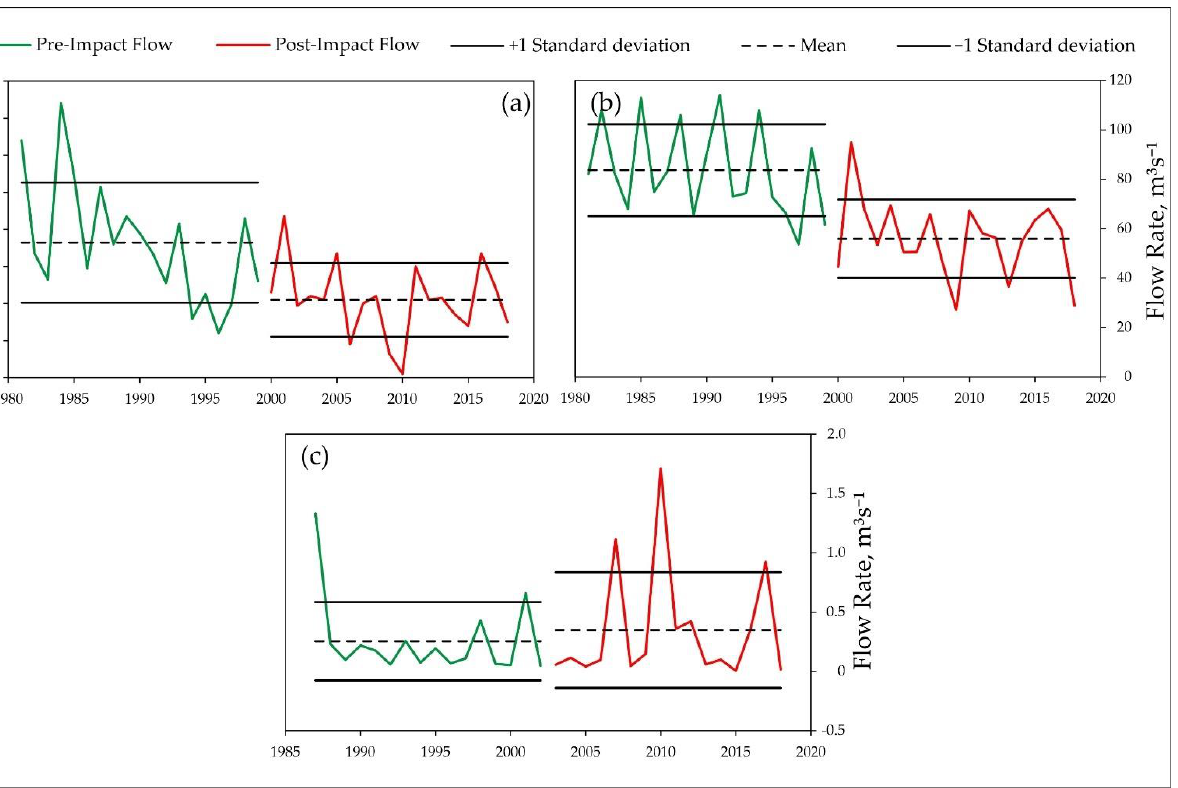
Table 6. Change (in days) in the means of the timing of annual extreme flows (group 3 of IHA parameters) and change (in %) in the mean frequency and duration of high and low pulses (group 4 of IHA parameters), as well as the rate and frequency of hydrologic changes (group 5 of IHA parameters).